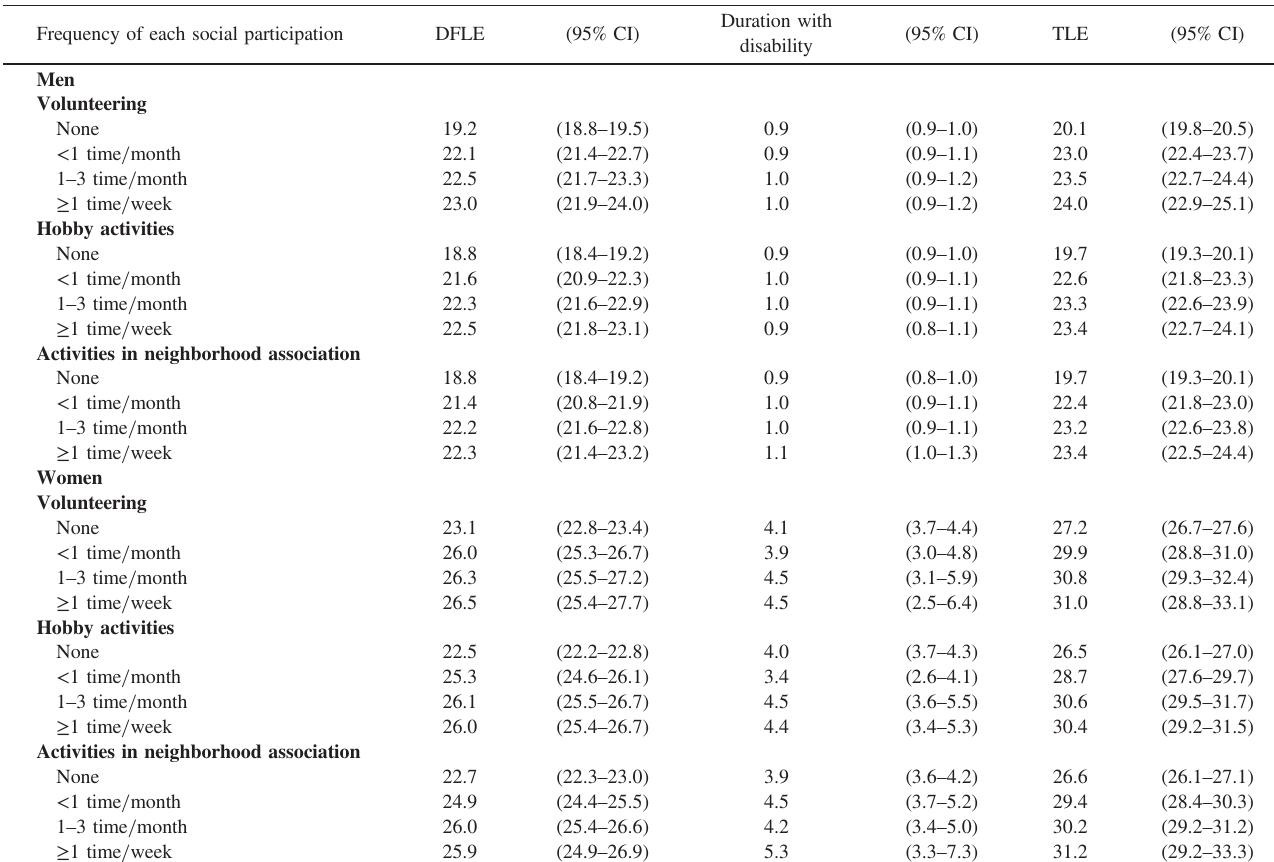
Table 4. DFLE, duration with disability, and TLE at 65 years by frequency of each social participation ( n = 11,982) Frequency of each social